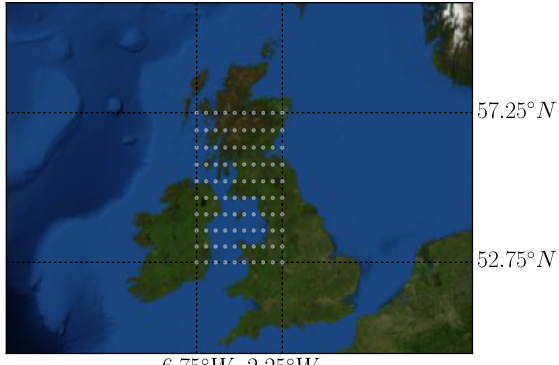
Figure 10. Locations used from the Copernicus dataset. Note the wide variety of the site locations, including both sea, high and low land.